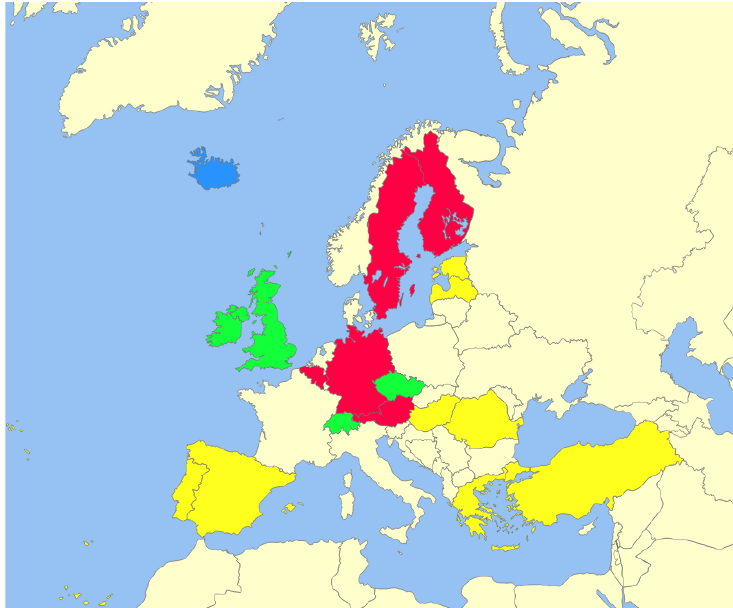
Figure 5. Four clusters of the press based on interventionism and the journalists’ perception of their role as promoting tolerance and cultural diversity.